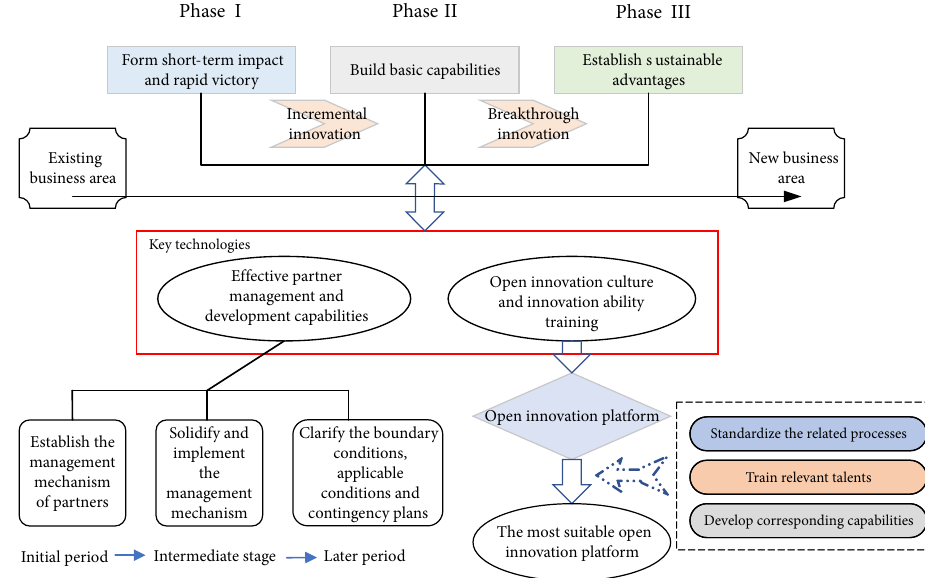
Figure 2. The main phases and key technologies of OI